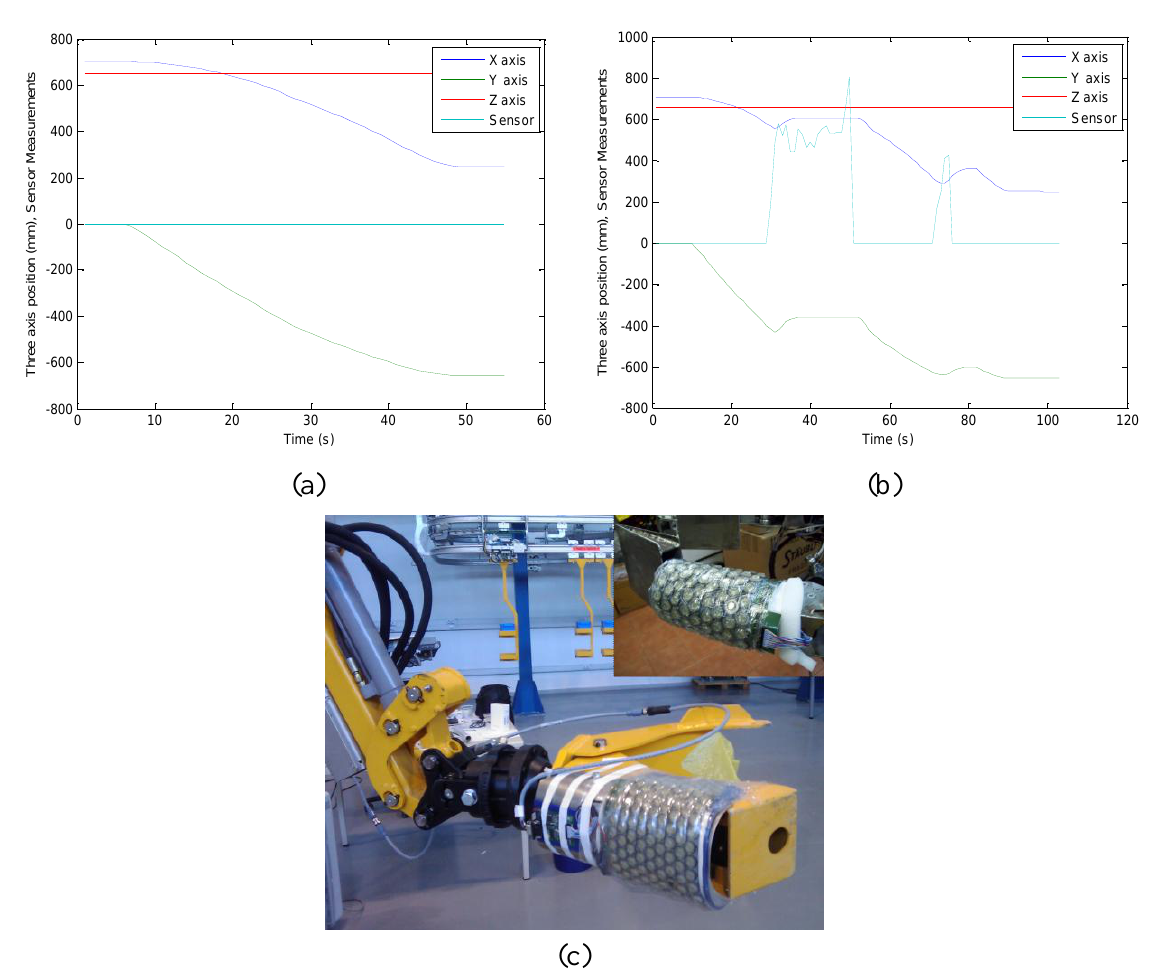
Figure 13. ( a ) Trajectories of the manipulator without contact, and ( b ) with two contacts. ( c ) Sensor mounted on the ALACRANE (the top right corner of the figure shows a detail where the sensor was mounted in a circular